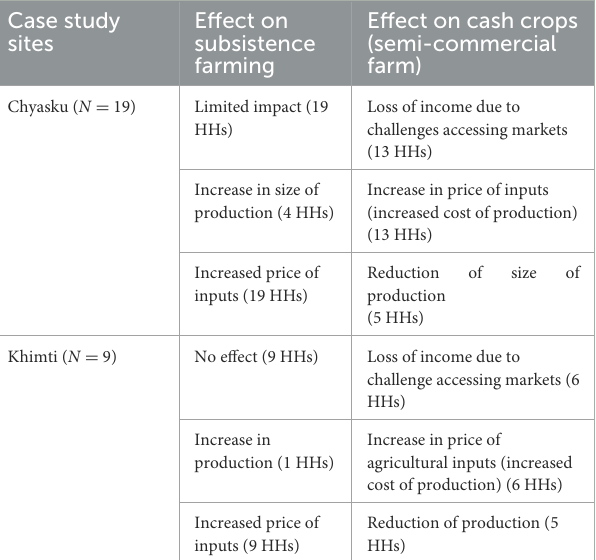
households’ overall estimates from the preceding year. However, subsistence consumption increased in the following months (August and October) in the context of continuing disruptions, before reducing again (Nov and Dec).